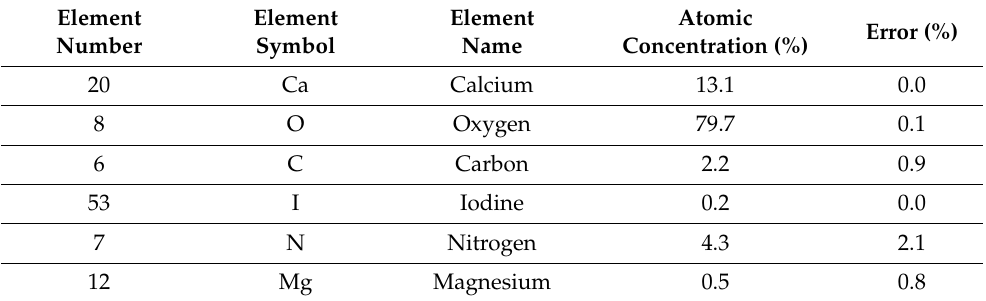
Table 1. Chemical composition of calcareous groats made using an energy-dispersive X-ray spec- trometer